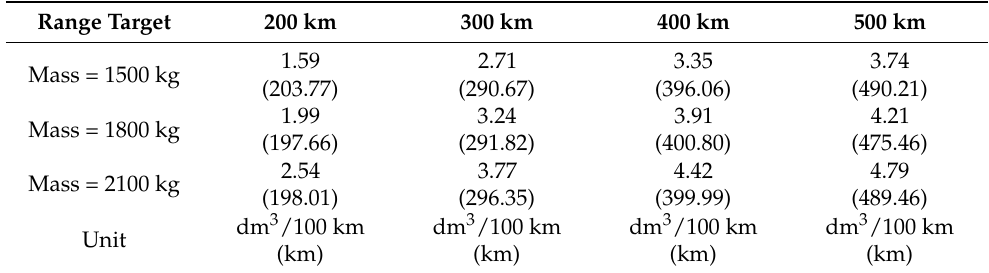
Table 18. Fuel consumption in EREV mode for CLTC-P.